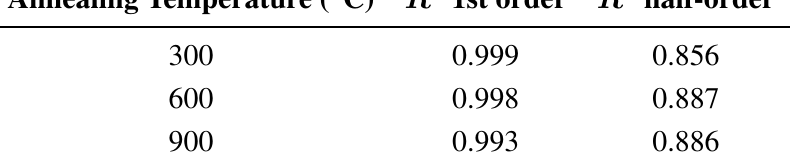
Table 1. Regression statistics for first- and half-order reaction